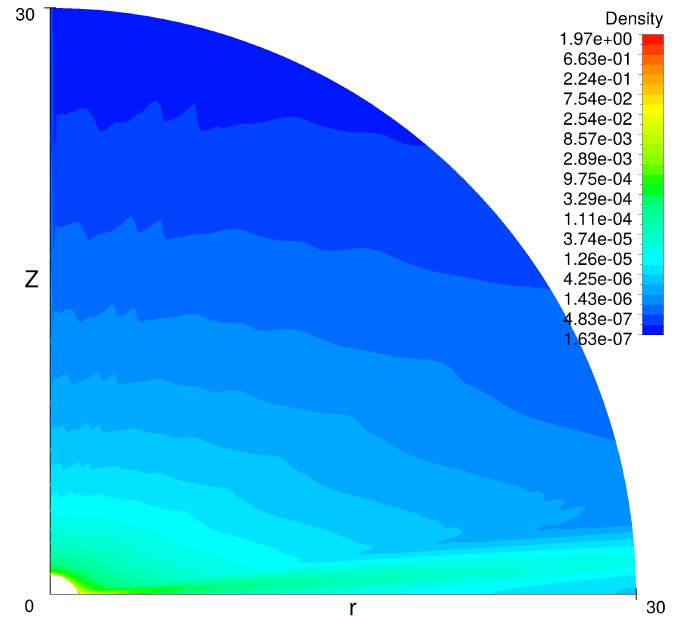
Figure 2. The density at ω =